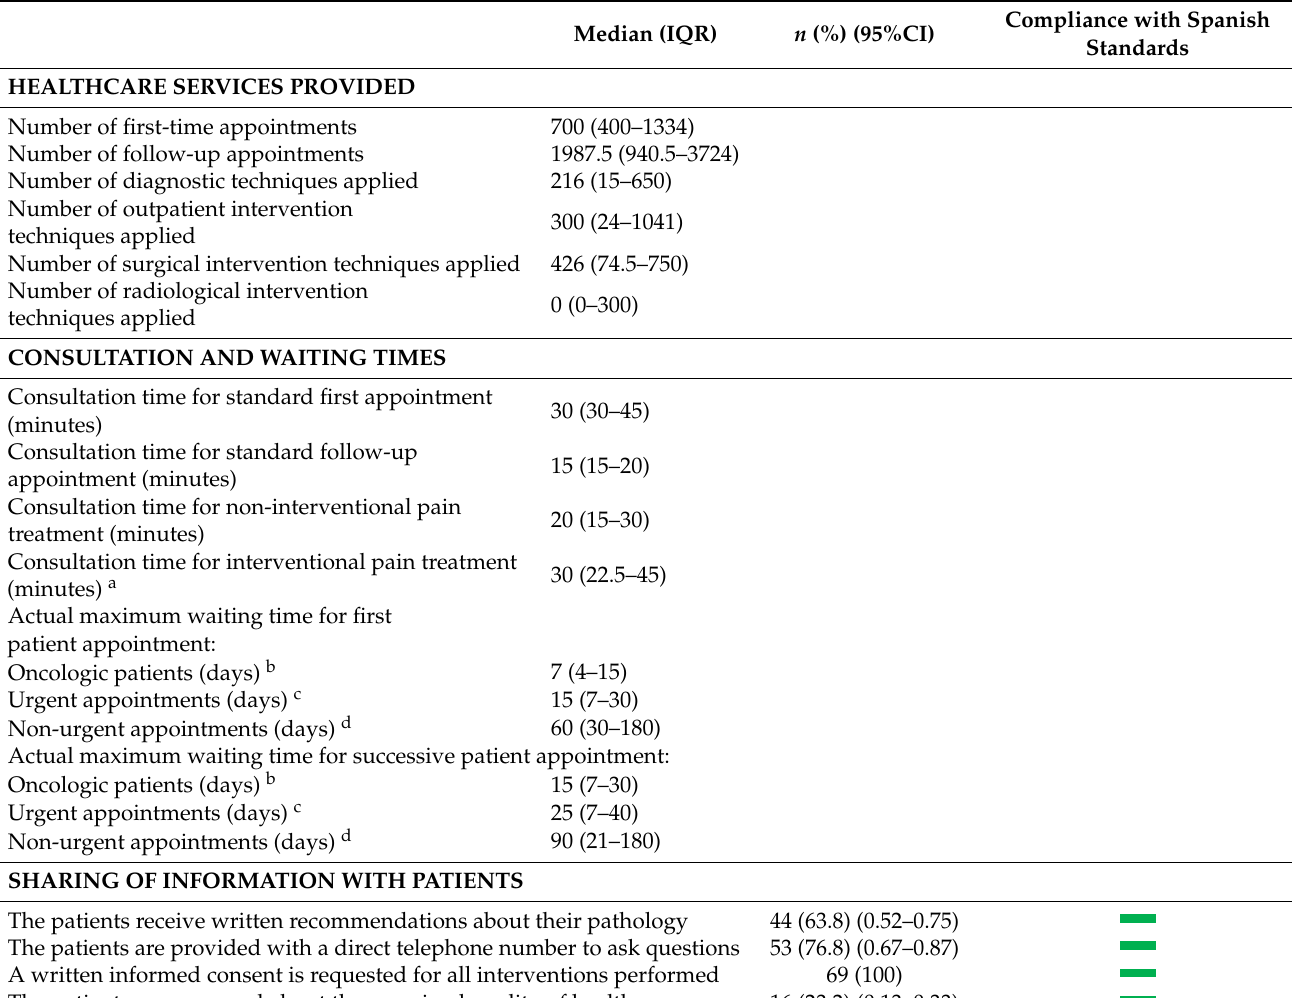
Table 2. Healthcare provision in a sample of Spanish pain units in 2018 ( n =